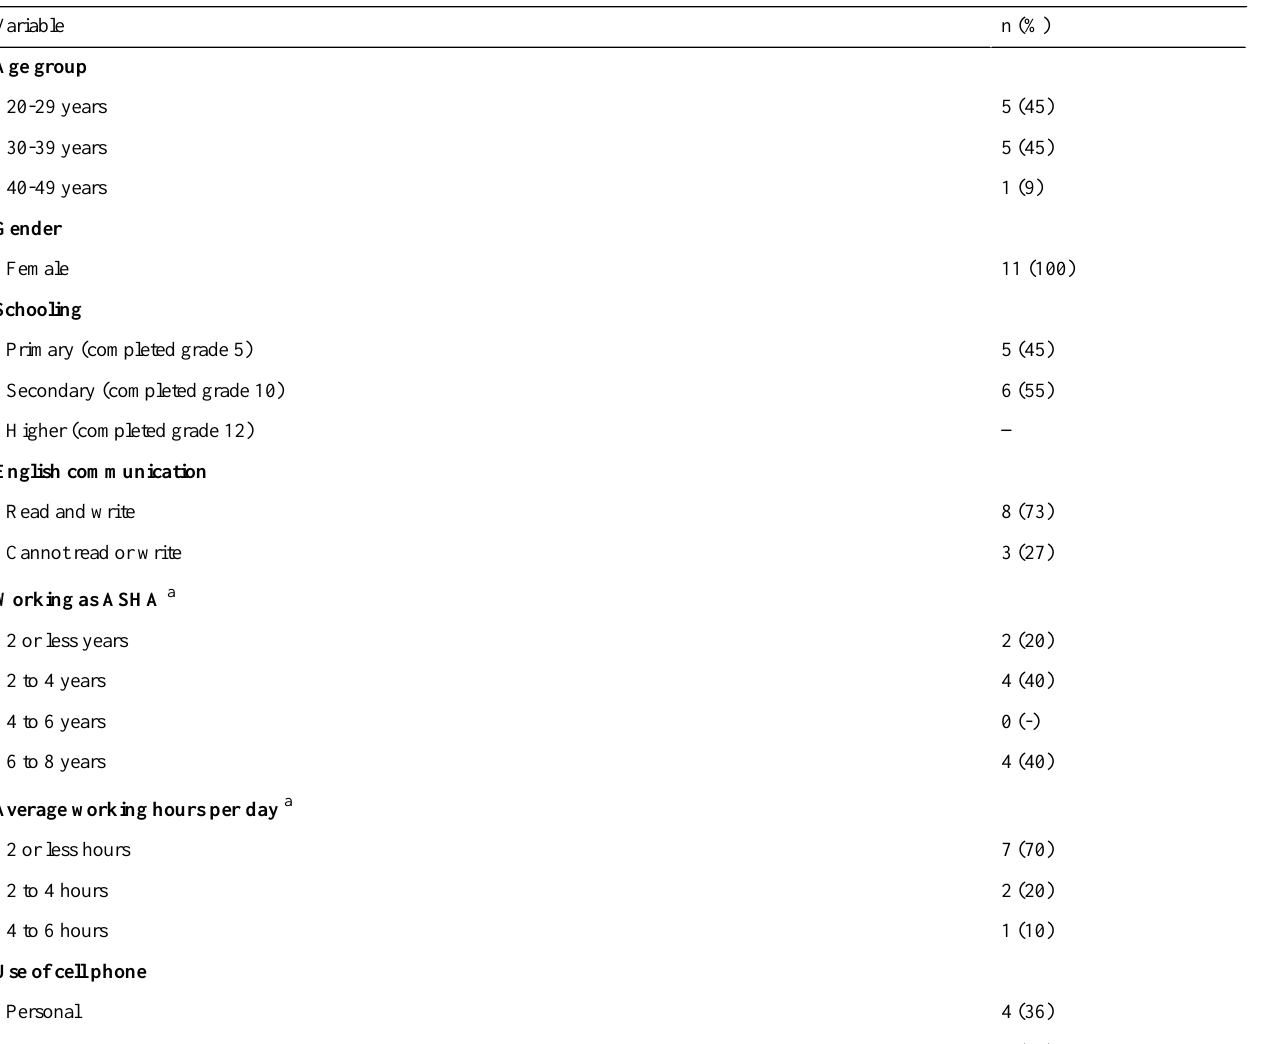
Table 1. Characteristics of health workers (ASHAs) in the study